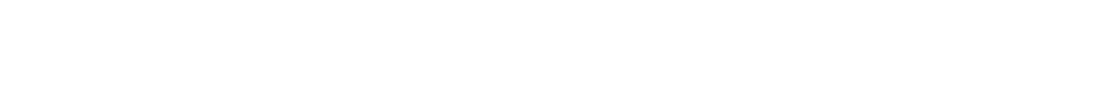
FIGURE 1 |The six buffer types and sub-buffers for one participant .The figure displays how some buffers are developed on the basis of the GPS track and directed toward the city center, while the more traditional buffers are created solely on home address and information derived via the geographical information